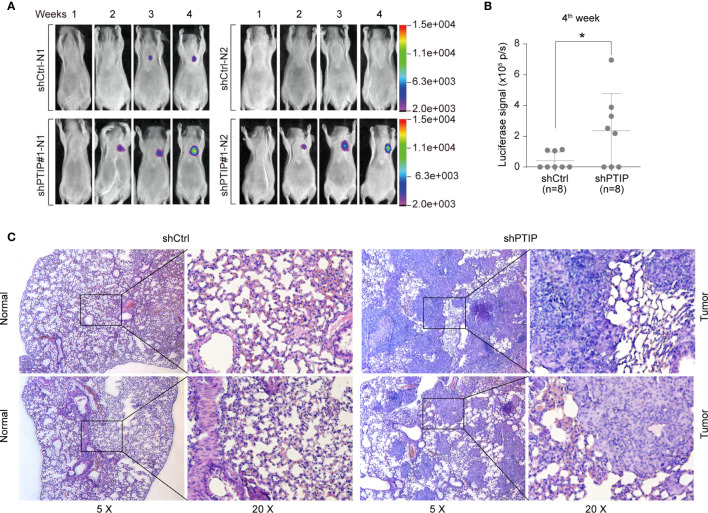
PTIP inhibits ESCC cell invasion and migration in vivo.
(A, B) The effect of PTIP knockdown on tumor growth and metastasis in a mouse model based on tail vein injection. KYSE-150 cells were infected with Scrambled shRNA (shCtrl) or shPTIP#1 lentivirus containing a constitutively expressed luciferase reporter. Then, shScrambled-treated or shPTIP cells were injected into mice via tail veins(n=8), and lung metastases in the two groups were evaluated by an in vivo imaging system(In-Vivo FX PRO). The luciferase signals were compared between the shCtrl group and the shPTIP group. Unpaired, two-tailed Student’s t-test; *P < 0.05. (C) Metastatic lesions in lungs from mice at the 4th week were analyzed by H&E staining. Overall staining patterns were shown at low magnification (original magnification ×5) as a composite figure and zoomed views (original magnification ×20) of the indicated areas (box).